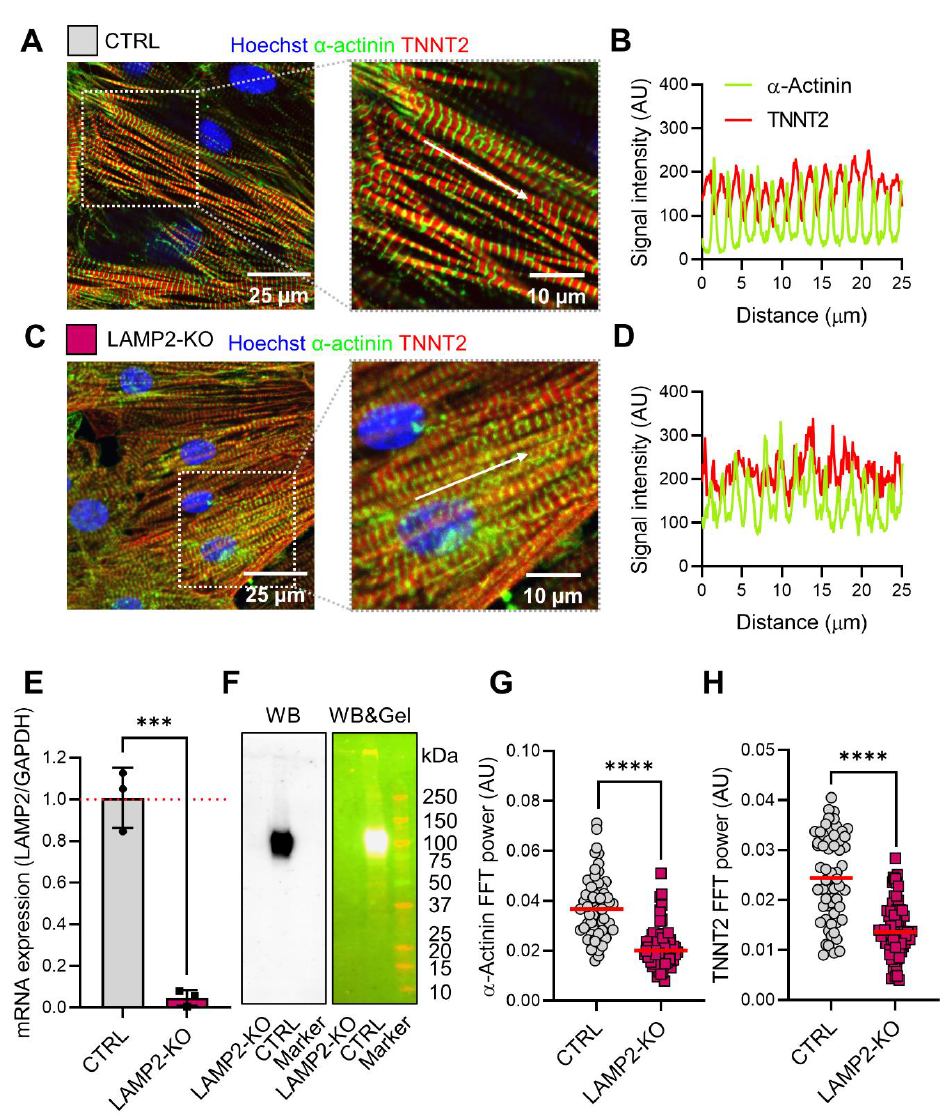
Figure 2. Morphological changes in LAMP2 KO iPSC-CMs. ( A ) Immunofluorescence staining of Ctrl iPSC-CMs with sarcomere markers (green for α -actinin and red for TNTN2) with detailed sarcomere structures shown in zoom-in view. White arrows indicate the sarcomere arrangement analyzed in detail in panel B; ( B ) Distribution pattern of α -actinin and TNNT2 signals along the sarcomere; ( C , D ) Immunofluorescence staining of sarcomere proteins in LAMP2 KO iPSC-CMs showed an irregular distribution of actinin and TNNT2 signals; € Quantification of mRNA expression of LAMP2 in both Ctrl and LAMP2 KO iPSC-CMs. Results from 3 independent experiments for Ctrl and LAMP2 KO group. Red dashed line indicates the ratio of LAMP2/GAPDH in Ctrl group was normalized to 1; ( F ) Western blot confirms the absence of LAMP2 protein in LAMP2 KO iPSC-CMs. Left: Western blot image; right: Western blot image merged with gel image indicates the predicted size of the target band; ( G , H ) Fast Fourier transformation analysis showed the regularity of α -actinin ( G ) and TNNT2 ( H ) signal distribution is significantly decreased in LAMP2 KO iPSC-CMs. N = 59 for Ctrl, N = 73 for LAMP2 KO. Data from at least 3 independent experiments. Red lines indicate the mean value of each group. *** p < 0.001, and **** p < 0.0001 versus Ctrl iPSC-CMs by unpaired